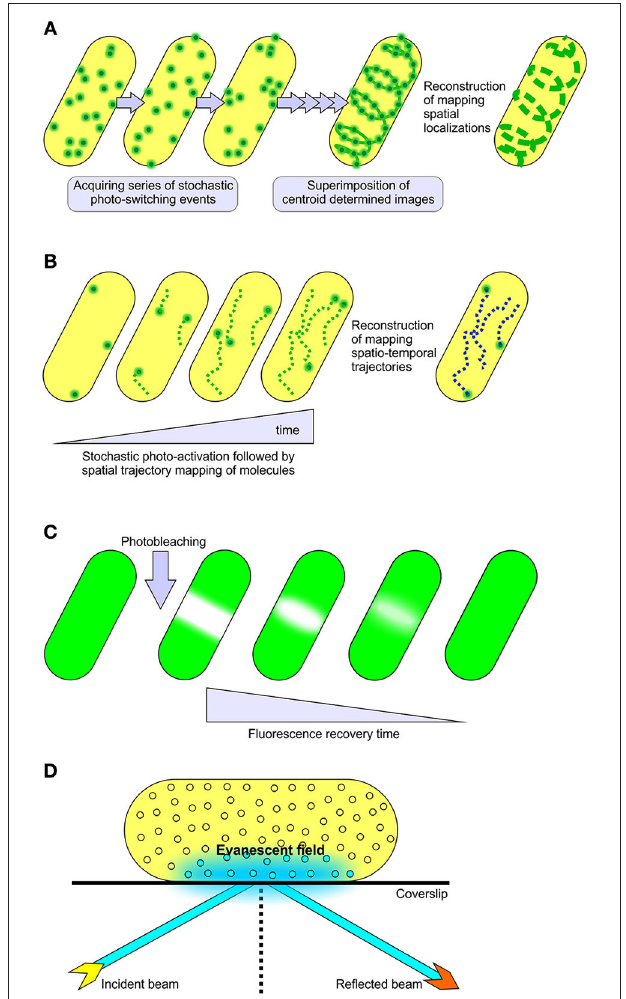
FIGURE 1 | Methods for single molecule localization and tracking. (A) STORM and (B) PALM super-resolution microscopy, collectively referred to as single molecule localization microscopy methods (SMLM). These modalities utilize stochastic photo-switching or photo-activation of a subset of fluorescence emitters to achieve sub-diffraction resolution of 10–25 nm in lateral dimensions. PALM is well known for live cell imaging and mapping spatiotemporal trajectories of individual fluorescently labeled molecules (Manley et al., 2008). STORM is documented for its use in determining the localized positioning of fluorescently labeled molecules in both live and fixed samples (Kamiyama and Huang, 2012). The mobility of fluorescent fusion proteins in live cells can also be surveyed through (C) FRAP and (D) TIRF microscopy techniques. In FRAP experiments, a relatively small area within the cell is irreversibly photo-bleached by a high intensity laser beam, followed by subsequent monitoring of the redistribution of non-bleached fluorescence molecules into the photo-bleached region under low laser power. TIRFM relies upon the generation of a rapidly decaying evanescent field at the interface of sample and coverslip to sparsely excite fluorophores, providing a high signal to background noise ratio in single particle tracking studies (Toomre and Bewersdorf,